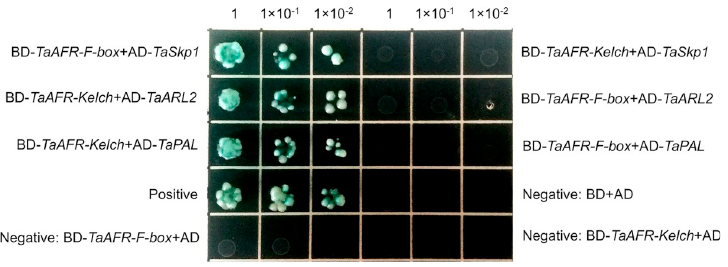
Fig 10. Domain interactions tested by Y2H. Yeast was cultivated on SD-WLHA+X- α -Gal plates for 3–5 days.